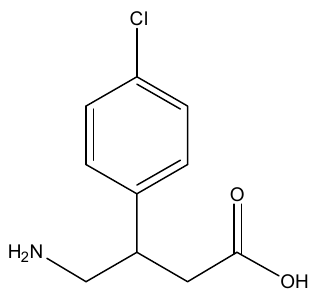
Figure 1. Structure of racemic